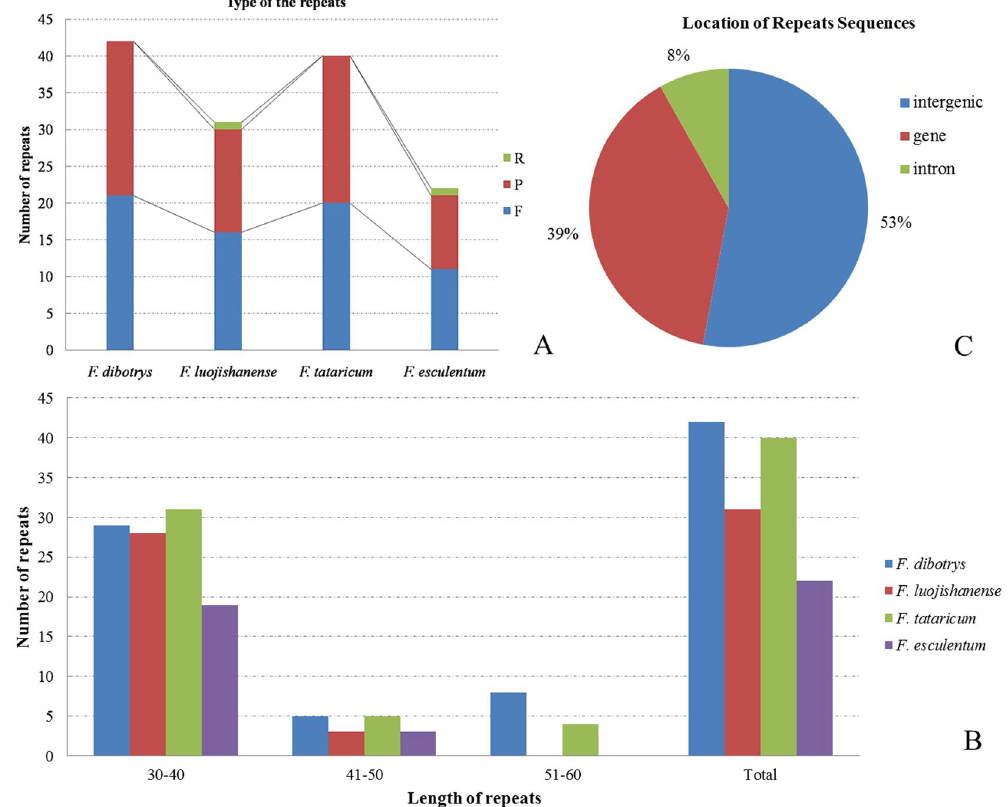
Figure 5. Numbers, repeat types and distributions of repeats in the four Fagopyrum chloroplast genomes. The letter F, P and R in Fig. 5A represent forward, palindromic and reverse